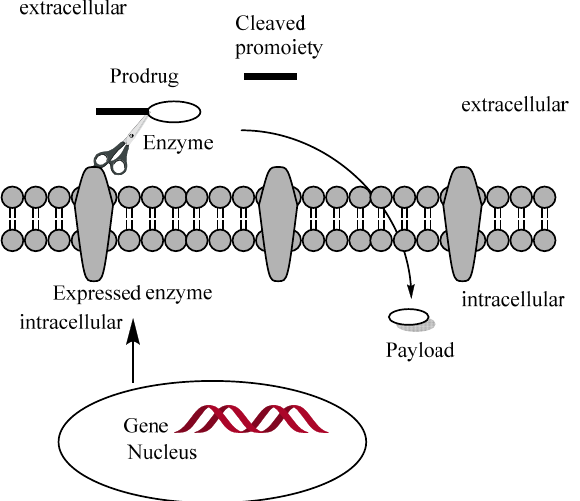
Figure 4. Cartoon illustrating the principle of gene-directed enzyme prodrug therapy (GEPDT)